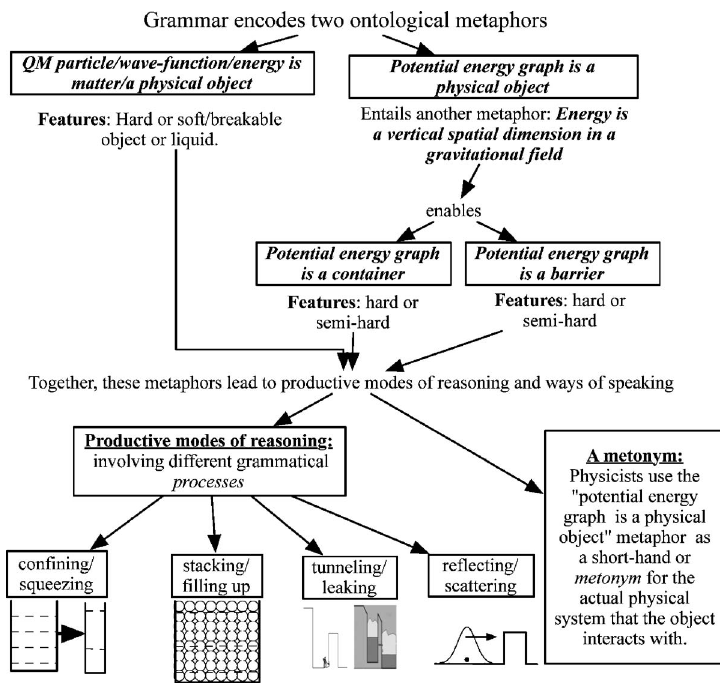
FIG. 3. Summary of the metaphorical system and its usage